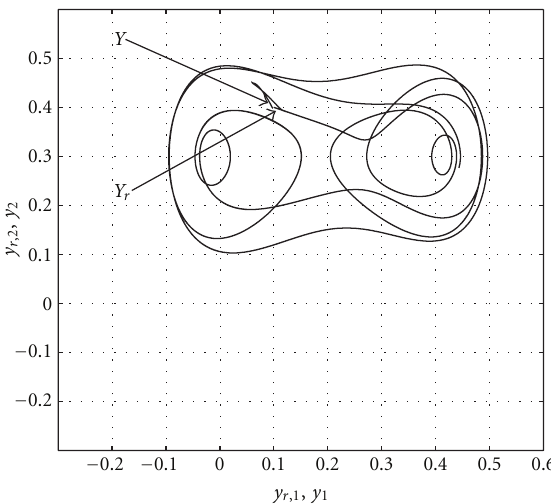
Figure 2: Tracking of the reference trajectory, using the robust